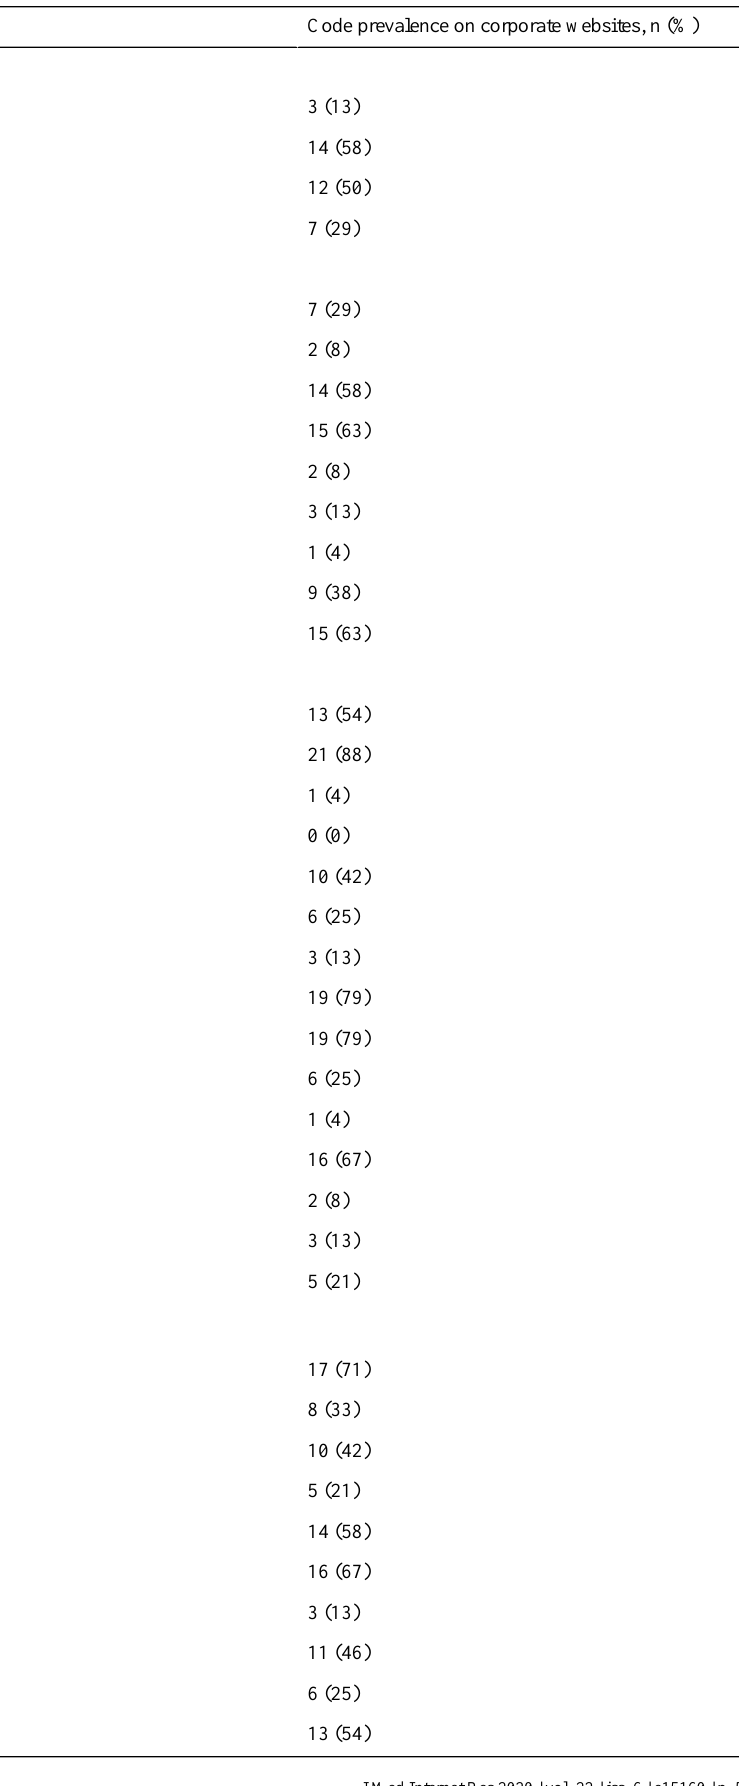
Table 1. Codebook used for corporate (n=24) websites and proportion of corporate websites by the presence of each code.